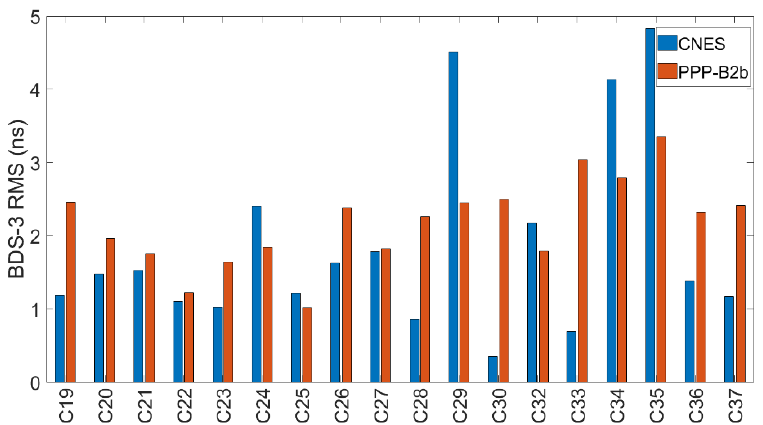
Figure 10. RMS values of BDS-3 clock errors for the PPP-B2b and CNES products.